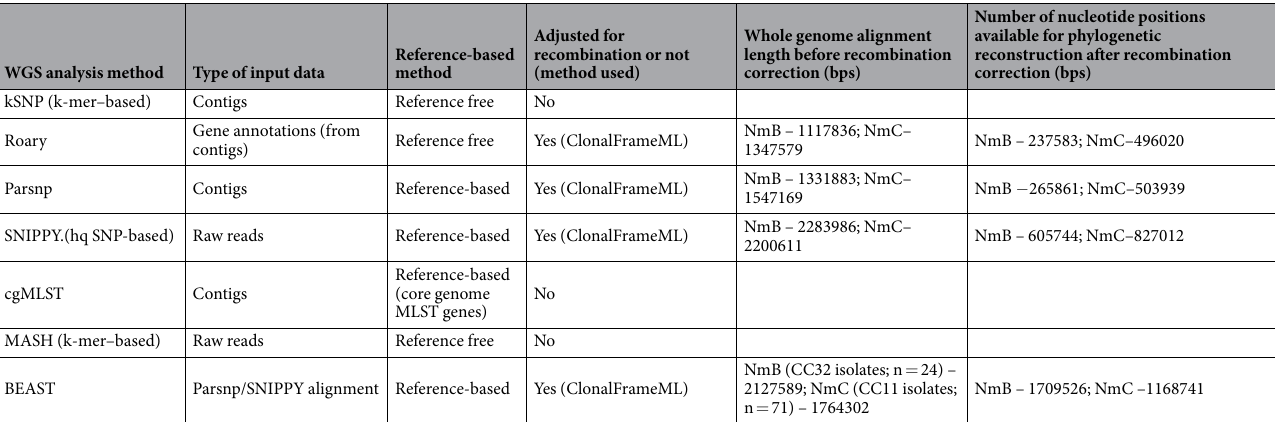
Table 2. WGS analysis methods evaluated in this